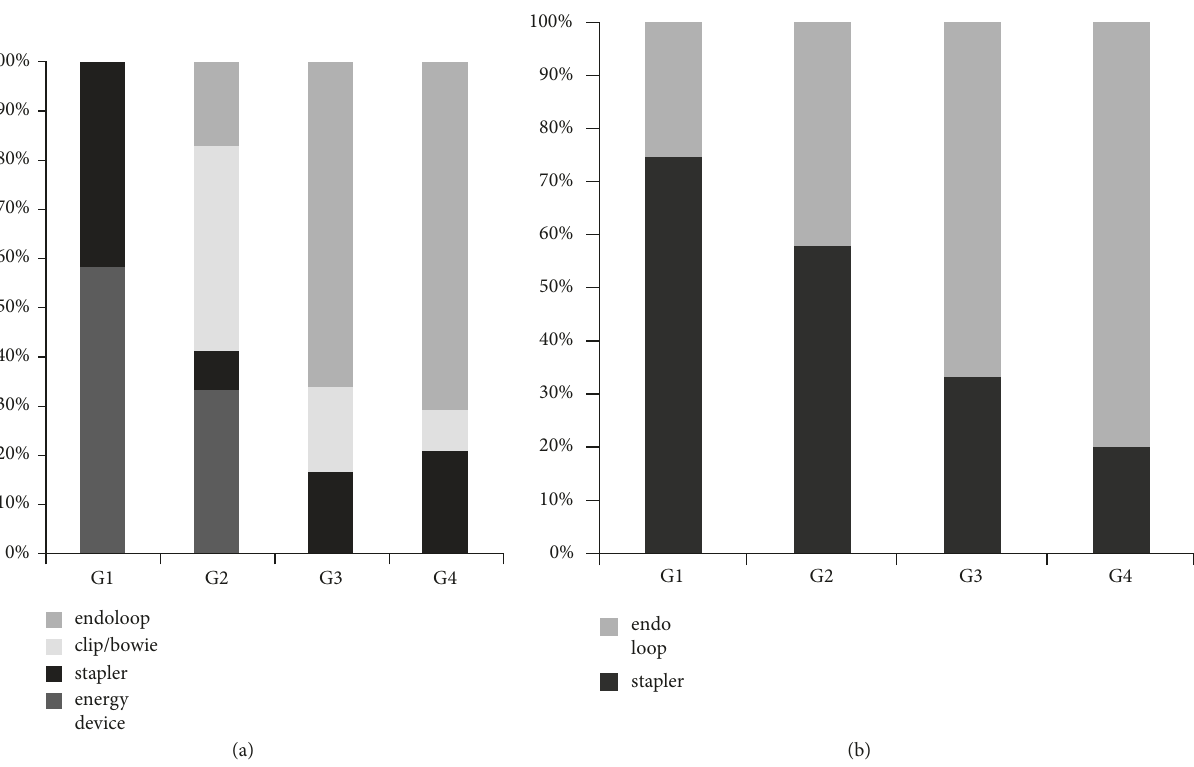
Figure 3: Operative data B: techniques to secure vascular pedicle and appendix. (a) The mesoappendix was initially secured with a stapler or energy device but in groups 3 and 4 mainly with an endoloop. (b) Appendix was initially mainly stapled off but in groups 3 and 4 mainly secured with an